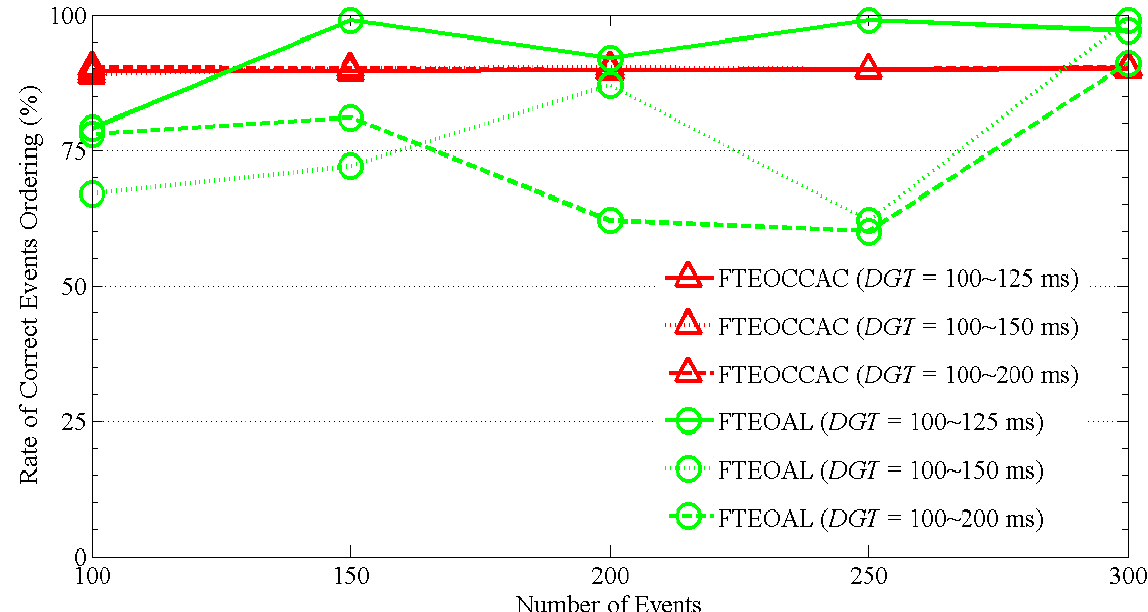
Figure 8. RC in FTEOCCAC and FTEOAL for different DTG ( P l = 0-30%, DT = 2000 ms, P l = 0-30%).